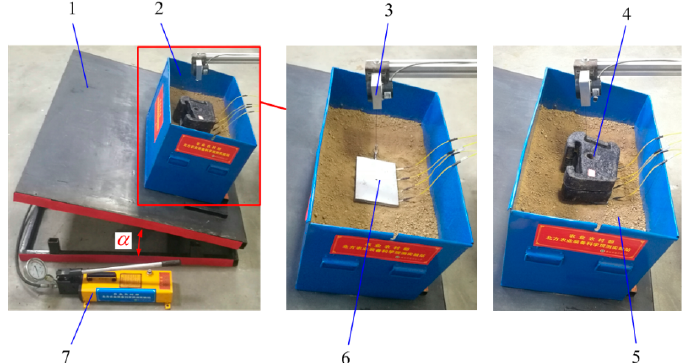
Figure 15. Validation test system. 1. Test bench; 2. Soil tank; 3. Displacement sensor; 4. Weight. 5.